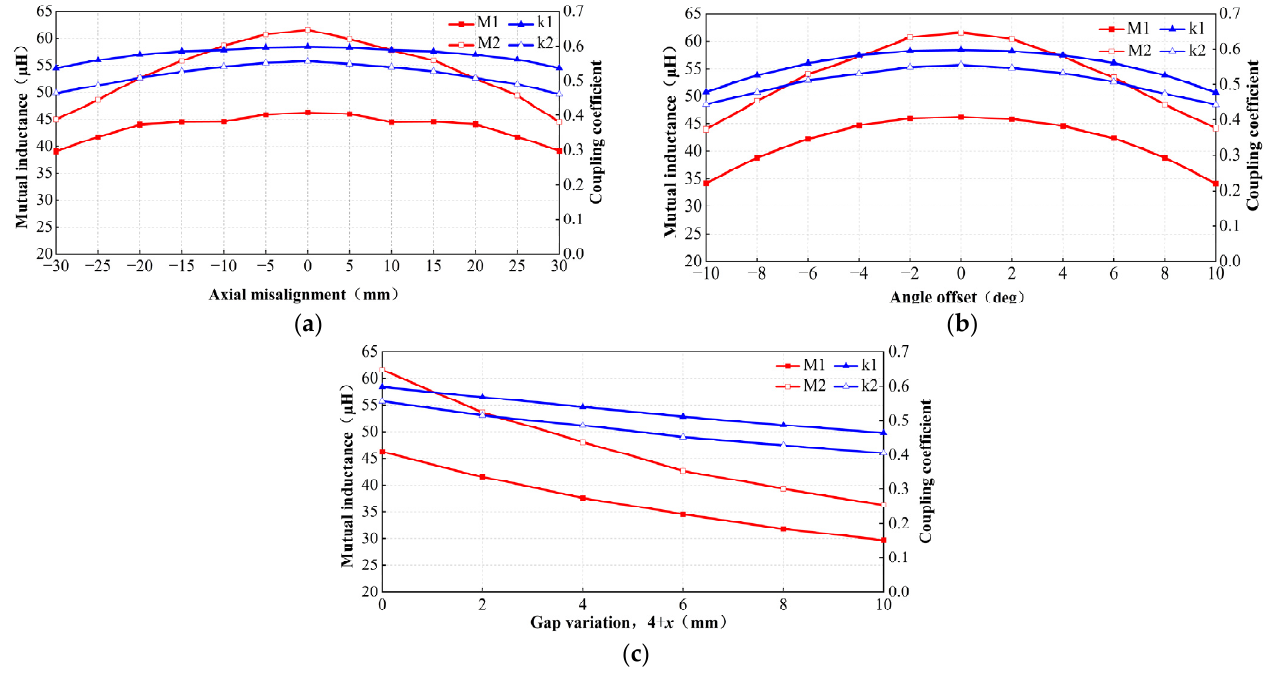
Figure 6. Variation curves of mutual inductance M and coupling coefficient k with three-dimensional misalignment. ( a ) Axial misalignment; ( b ) Angle offset; ( c ) Gap variation.